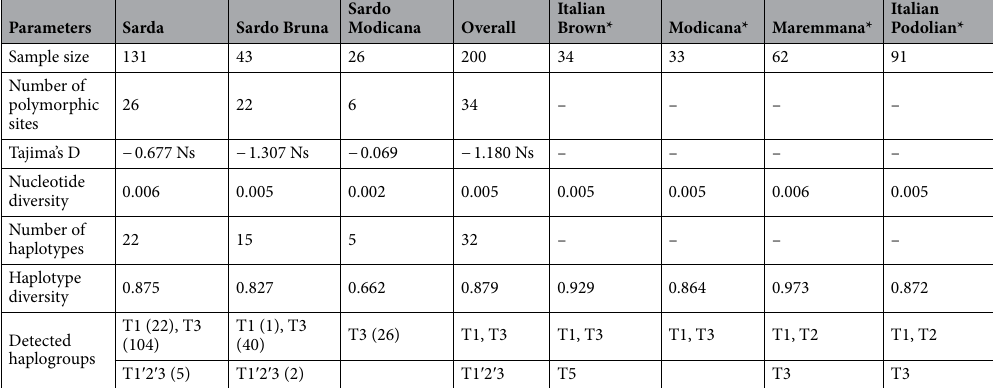
Table 1. Distribution of mtDNA haplotypes in three local cattle breeds from Sardinia (616 bp mapping to the hypervariable region, range 15,792 – 69 of acc. no. V00654). *Di Lorenzo et al. 19 . The range of the mtDNA hypervariable region was 15,823–215. Ns, non